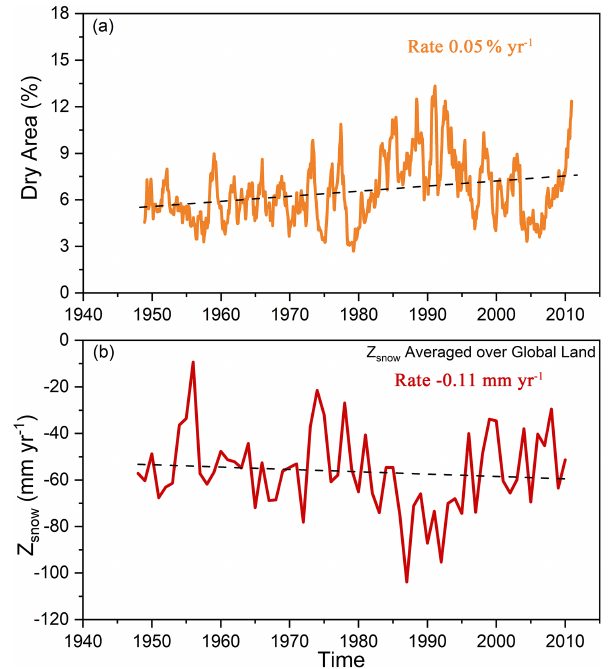
Figure 8. Time series of (a) global dry land area (%yr − 1 ) and (b) Z snow (mmyr − 1 ) between 1948 and 2010. The dry land area was calculated based on the SZI snow at a 12-month timescale. The dashed lines denote the linear trends.